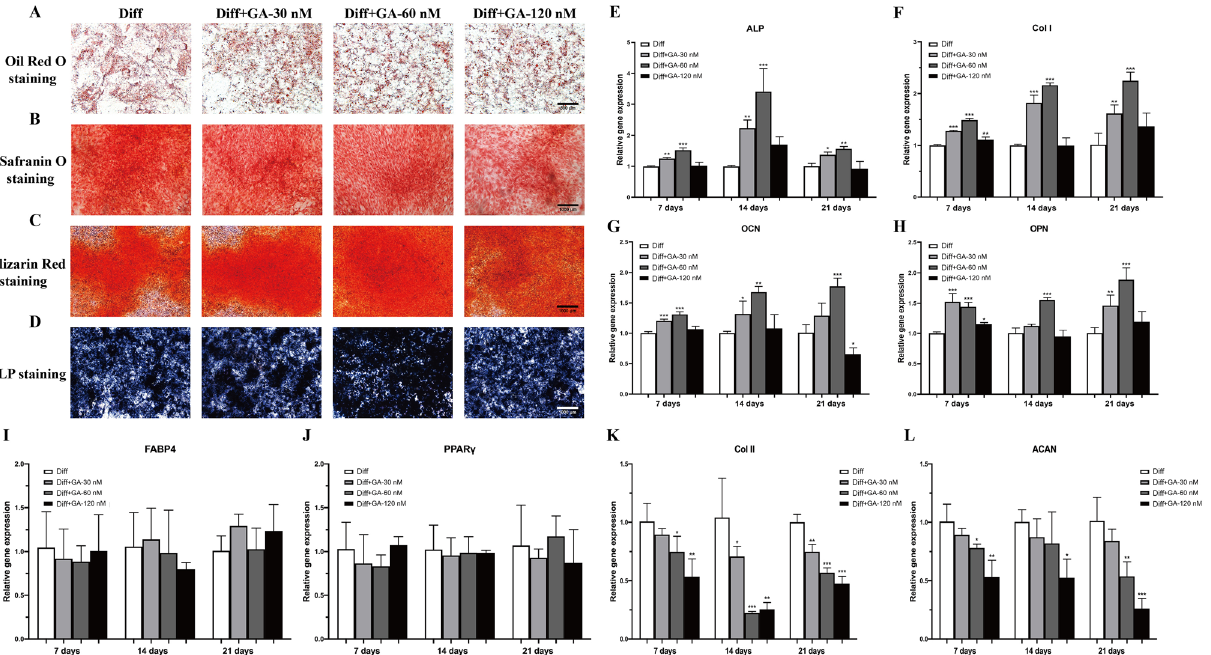
Figure 6. The effect of His6-GABARAP on BMSCs differentiation. Adipogenesis and chondrogenesis differentiation of BMSCs were verified by Oil Red O ( A ) and safranin O ( B ) staining, respectively, in 21 days. Qualitative assessment of calcium deposition in BMSCs was stained by Alizarin Red ( C ) and ALP ( D ) staining in 21 days. qRT-PCR was used to analyze the gene expression levels of ALP ( E ), Col I ( F ), OCN ( G ), OPN ( H ), FABP4 ( I ), PPARγ ( J ), Col II ( K ), and ACAN ( L ) during differentiation. Diff (with corresponding differentiation); Diff + GA-30 nM (with corresponding differentiation and 30 nM His6-GABARAP); Diff + GA-60 nM (with corresponding differentiation and 60 nM His6-GABARAP); Diff + GA-120 nM (with corresponding differentiation and 120 nM His6-GABARAP). Values are the means ± SD, n = 3. * p < 0.05, ** p < 0.01, *** p < 0.001 relative to the Diff group. Scale bar, 500&1000